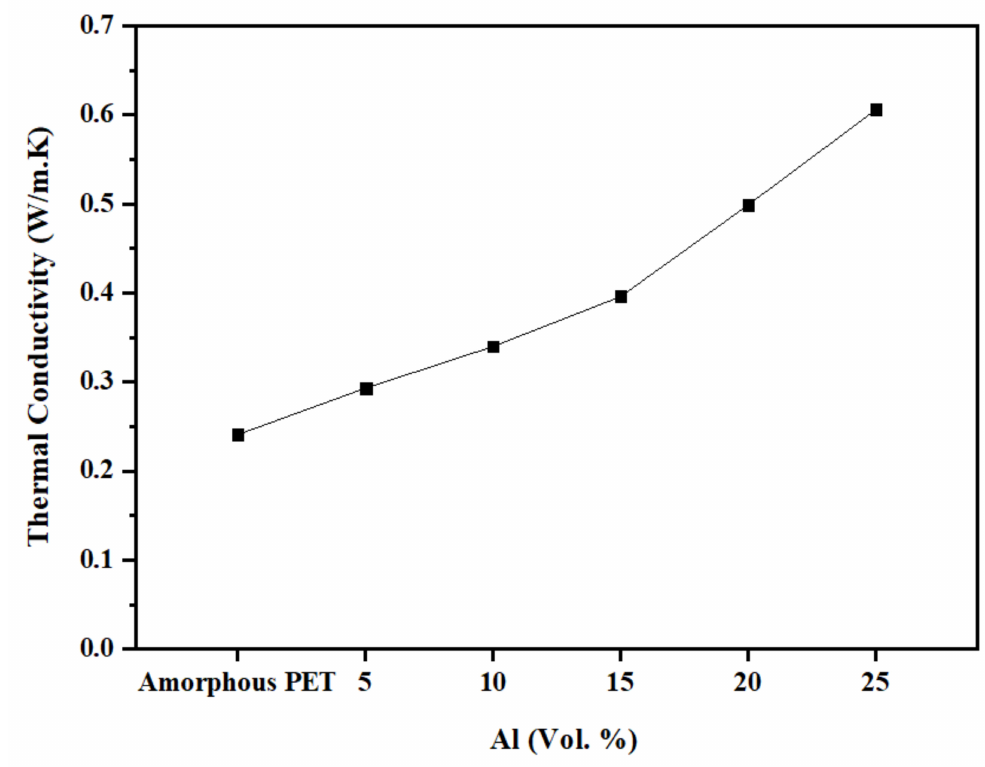
Figure 21. Thermal conductivity as a function of Al